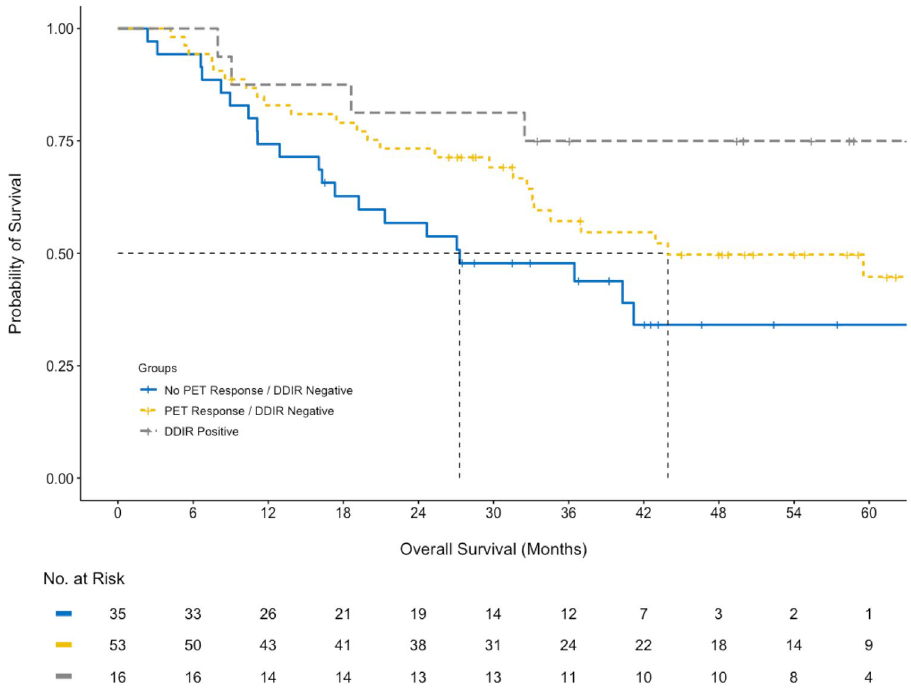
Figure 5. Cumulative overall survival differences between three groups; no PET response and DDIR negative, PET response and DDIR negative, and DDIR positive. The latter group comprised both PET responders and non-responders because only nine patients had no PET response and were DDIR positive.